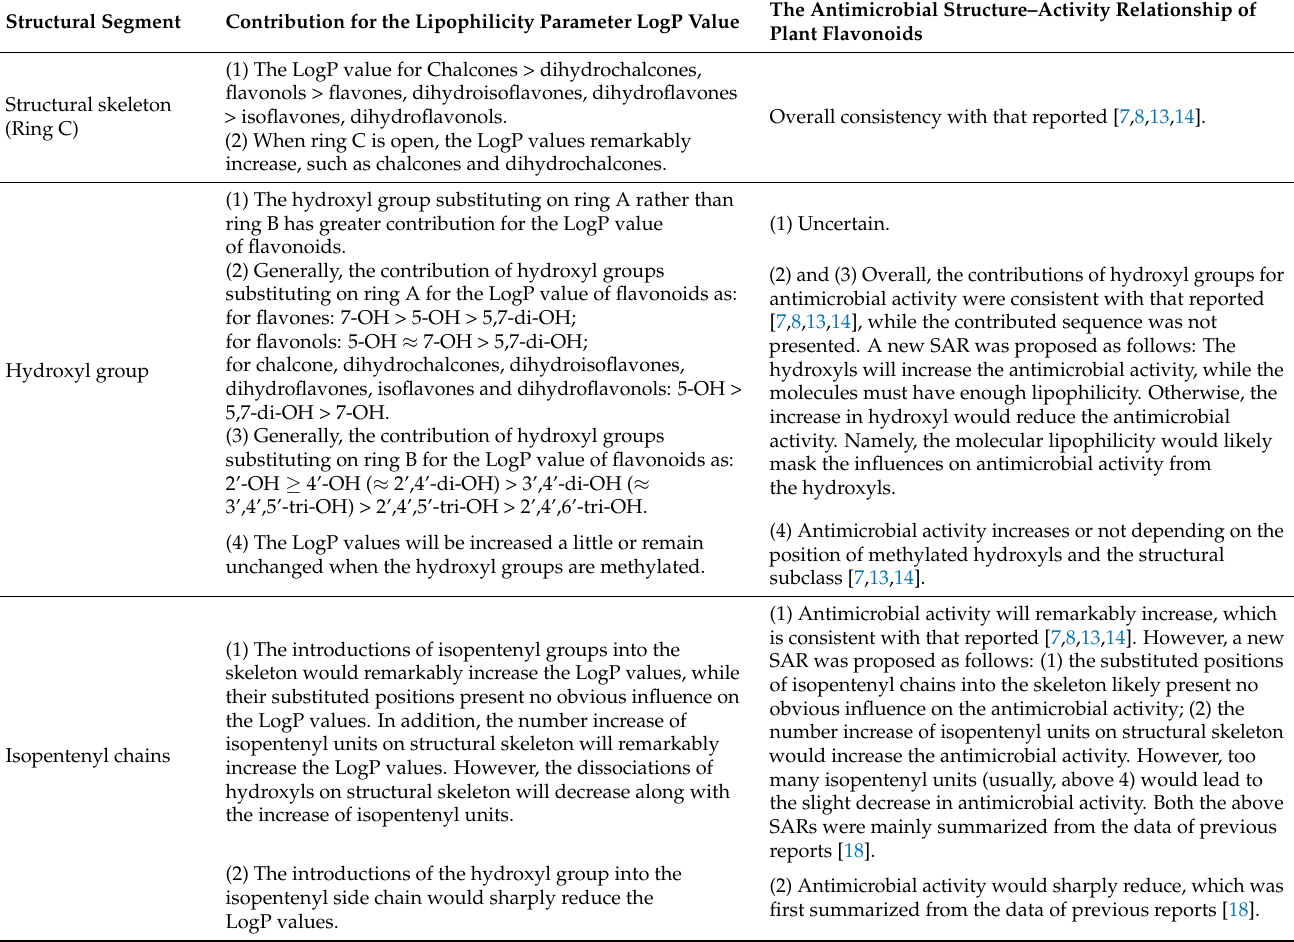
Table 4. The relationship between the structure and the lipophilicity (LogP) and some novel structure– activity relationships of plant